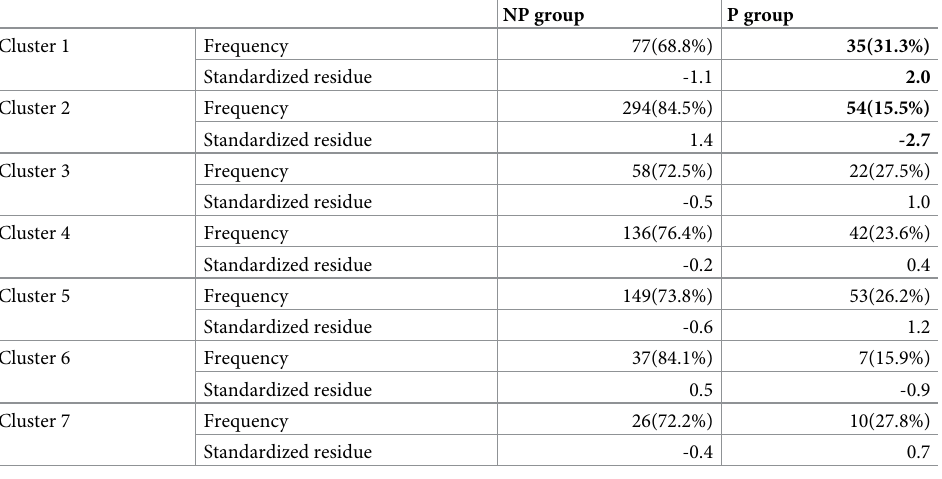
Table 5. Results of Chi-square analysis concerning “perception of